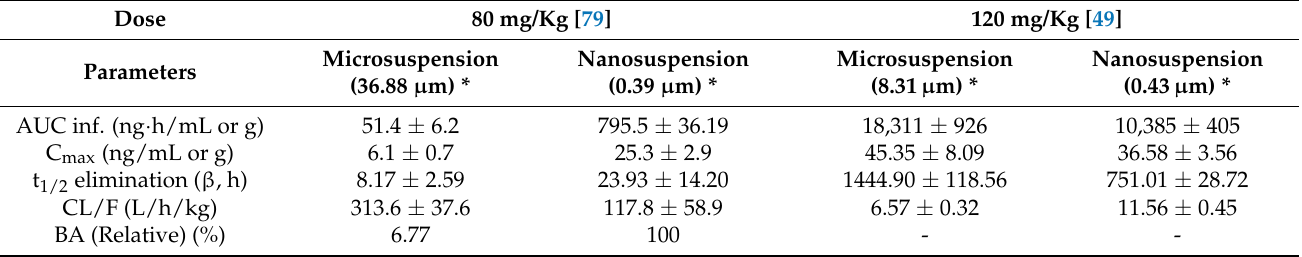
Table 2. In vivo pharmacokinetic parameters of micro- and nanostructured DQ after oral administration (80 mg/Kg) to male ICR mice [79] and intramuscular administration (120 mg/kg) to male ICR mice [49]. 80 mg/Kg